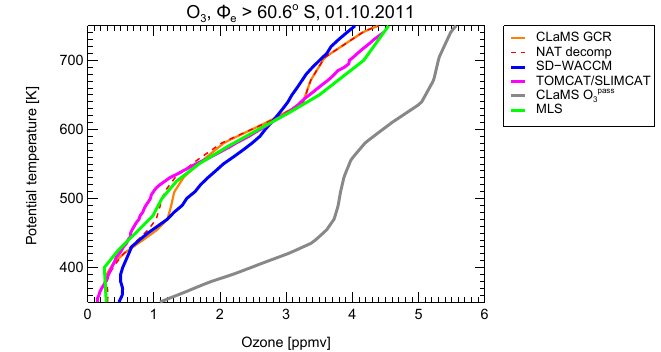
Figure 14. Simulated vortex mean ozone profile for 1 October 2011 from MLS (green) and different model runs of SD-WACCM (blue), TOMCAT/SLIMCAT (pink) and CLAMS (GCR, orange). The re- sults from the “NAT decomp” sensitivity simulation are shown as a red dashed line. The grey line corresponds to the CLaMS passive ozone tracer and the difference with the other lines indicates the chemical ozone